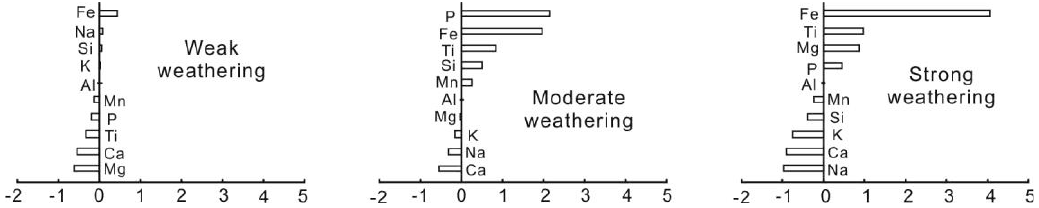
Figure 4. The mass transfer coefficients τ j of 3 groups of different chemical weathering intensities relative to their parent rocks. Al is used as a stable element.